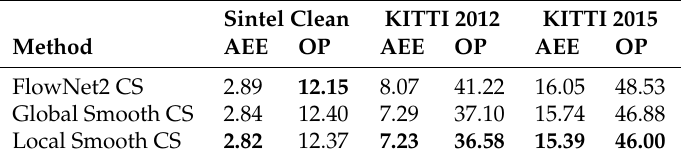
Table 1. Global vs. local smooth results trained on FlyingChairs with long scheduling.